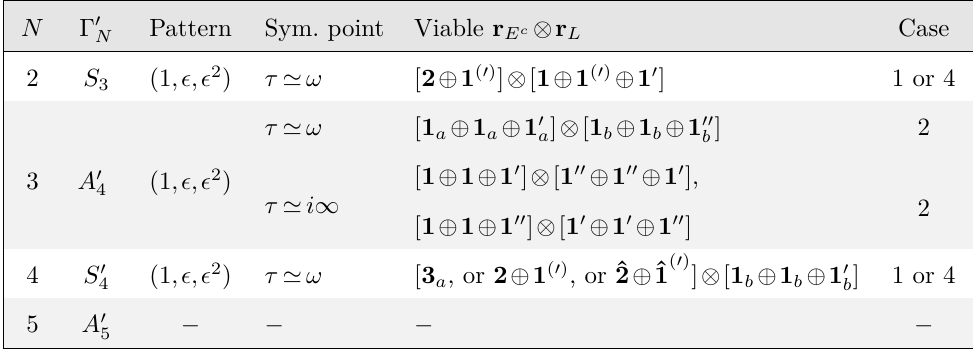
Hierarchical charged-lepton mass patterns which may be realised in the vicinity of symmetric points without fine-tuned mixing (PMNS close to the observed one in the symmetric limit). The property which is satisfied (from 1-4, see text) is given in the last column and may depend on the weights k and k c . The case N = 3 with τ ’ ω is the only one in the table for which r E c ↔ r L may be required, and for which not all k ( c ) choices are viable. For other notation,